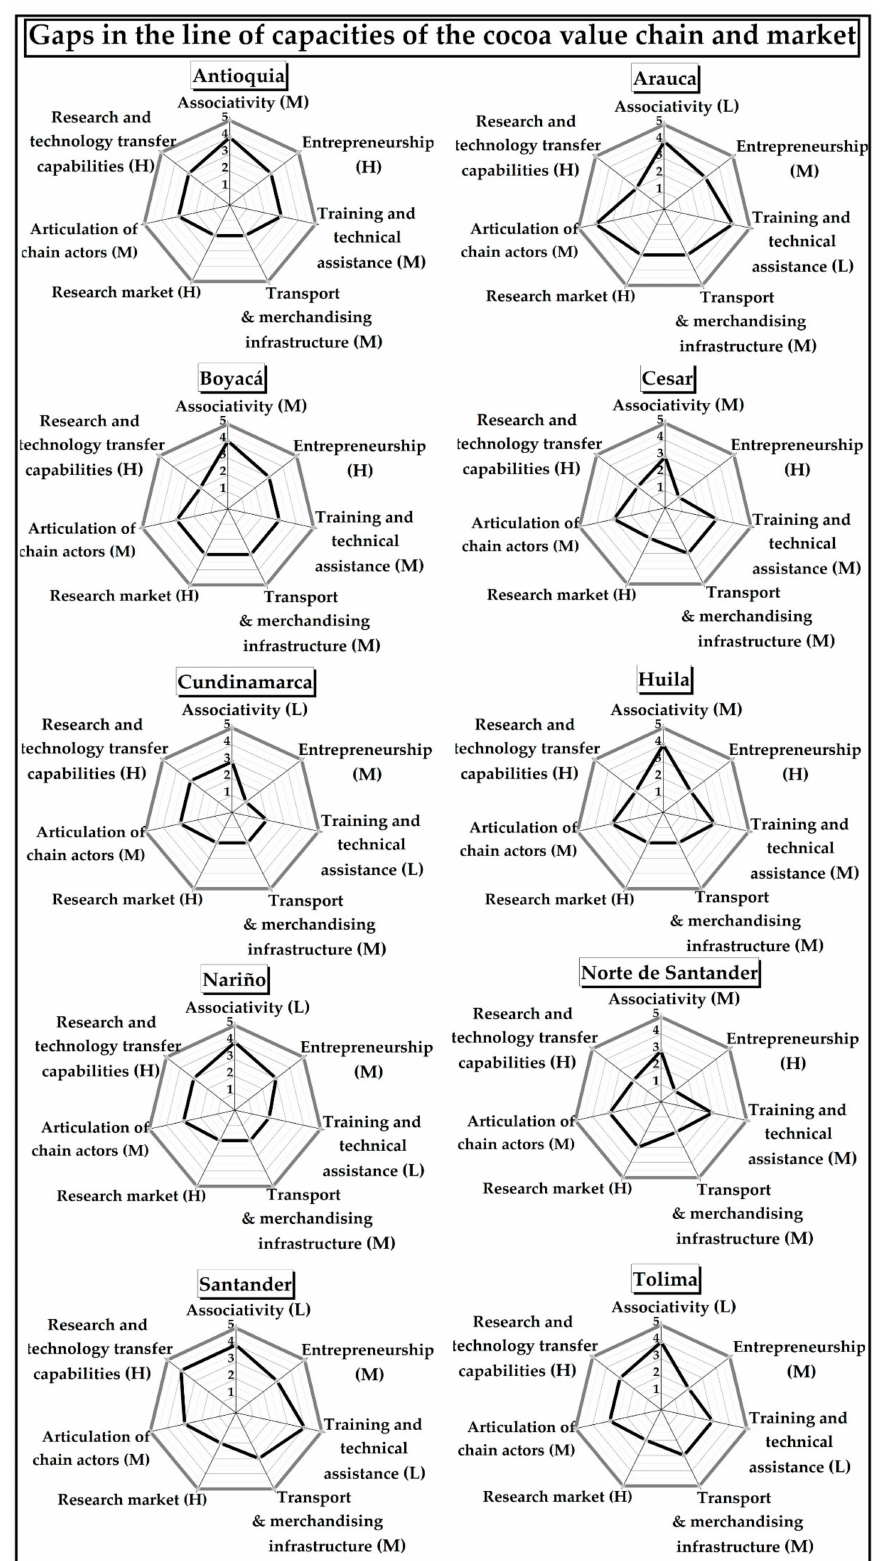
Figure 10. Main gaps identified in the strategic line of capacities of the cocoa value chain and market: Regional reality (black line) versus best practice / scenario (gray line). Next to each variable, the qualitative assessment of the gap is indicated in parentheses: high (H), medium (M), or low